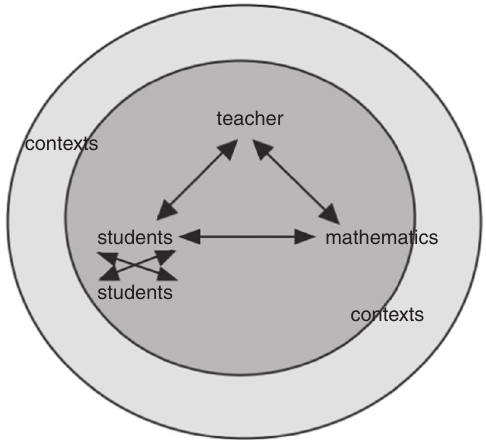
Figure 1. Instructional